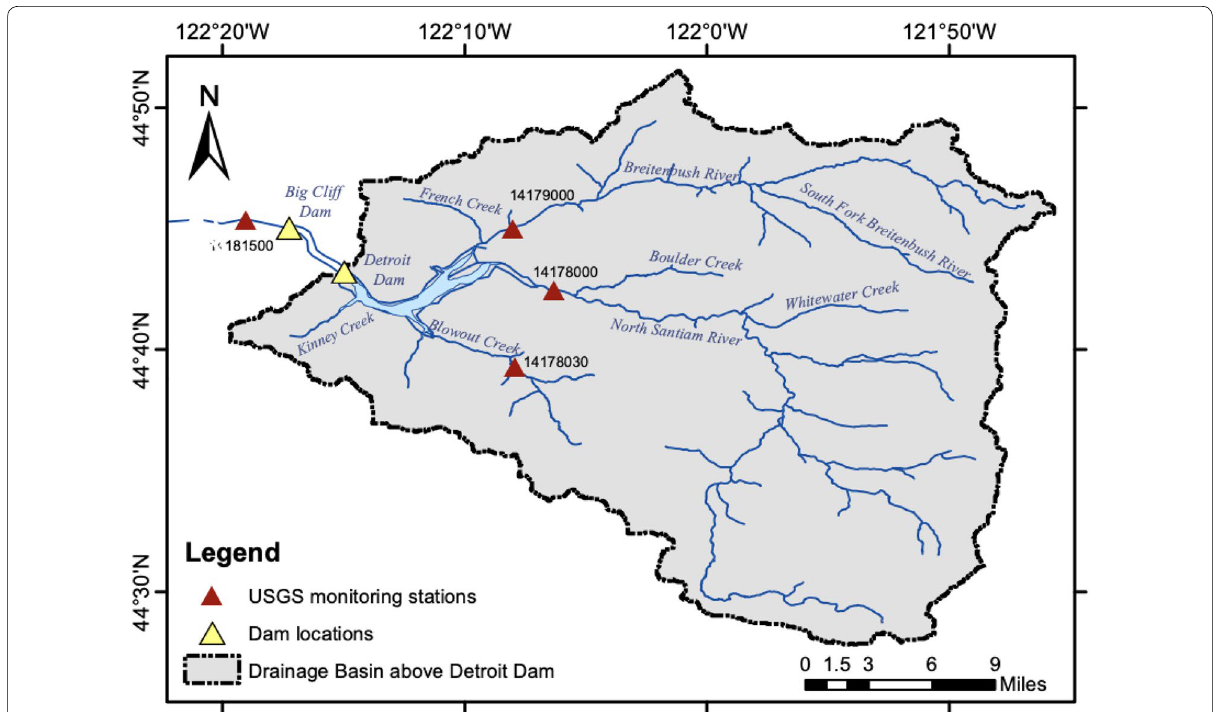
Fig. 2 Drainage basin above Detroit dam (OR) and pertinent USGS monitoring stations used in the study